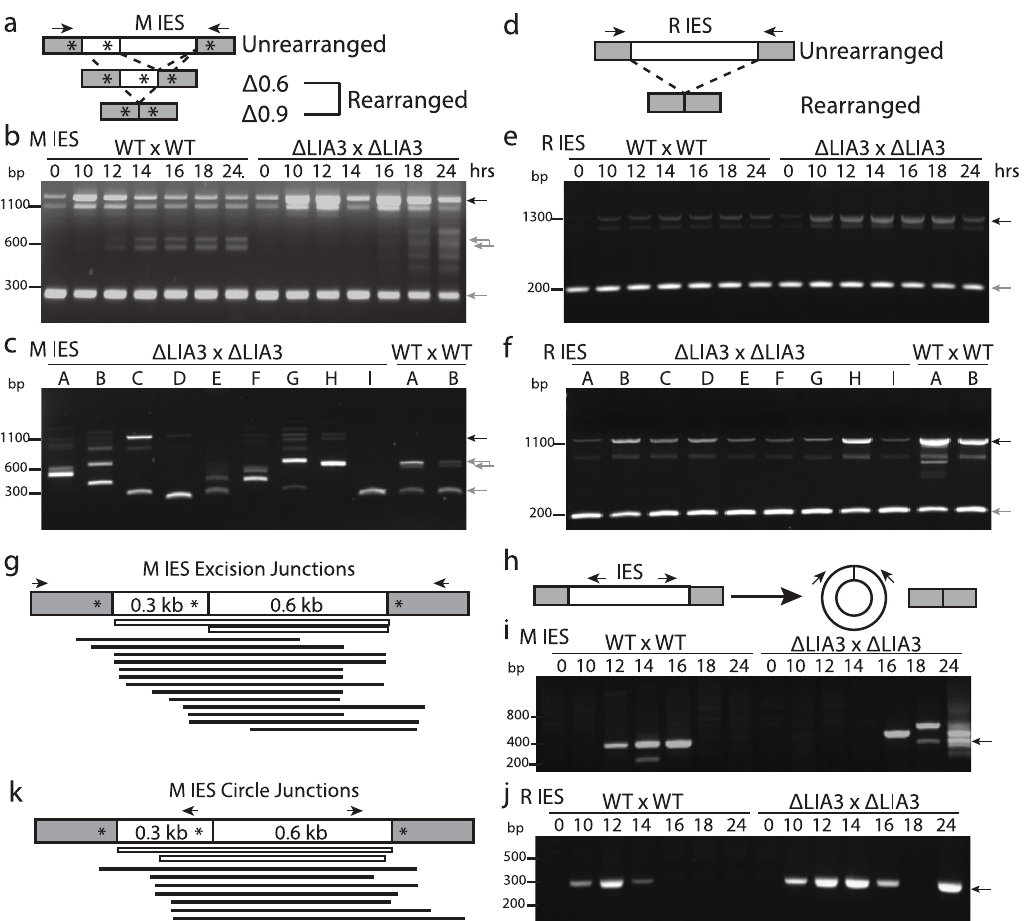
Fig 2. Excision of the M IES is aberrant and delayed in Δ LIA3 matings. (a and d) Diagram illustrating the alternative rearranged forms of the M IES (a) or R IES d). Grey boxes represent the macronucleus retained flanking regions; white boxes, the 0.6 kb and 0.3 kb eliminated sequences; asterisks, the A5G5 tracts; arrows, the location of the pcr primers used in b and c to amplify across the IES. (b and e) PCR of genomic DNA isolated from different timepoints throughout mating demonstrating that excision of the M IES (b) is both delayed and aberrant in Δ LIA3 matings while excision of the R IES is normal (e). (c and f) PCR of individual progeny confirming that excision of the M IES (c) is aberrant in Δ LIA3 matings whereas excision of the R IES (f) is comparable to WT matings. Black arrows point to the unrearranged form and single and double grey arrows point to the expected rearranged forms for b, c, e, and f. In b and c, the doublet observed for the 0.6 kbp M IES deletion reveals that some fraction of wild-type excision events are directed by a cryptic A5G5 tract (AAAGGAGG) rather than the major A5G5 boundary determinant. (g) Diagram displaying the sequenced junctions from individual Δ LIA3 progeny. A diagram of the M IES denotes the two alterative left boundaries, M1 and M2, and the right boundary M3. Within the IES diagram grey boxes represent the flanking regions; white boxes, the 0.6 kb and 0.3 kb eliminated region of the M IES; asterisks, A 5 G 5 tracts; arrows, pcr primers. Each thin, white and black boxes beneath the IES diagram represents the region excised from the progeny of either wt or Δ LIA3 matings, respectively. (h) The strategy to detect excised IES circles: PCR primers located within each IES point outward toward the boundaries and will only amplify a product if the excised region forms a circular intermediate. Grey boxes represent the flanking region; white boxes, the excised region; arrows, pcr primers. (i) PCR results for the excised M IES throughout mating. Primers will not amplify circular products utilizing the interior, right deletion boundary. Note: the lower band in the 14 hr WT mating sample corresponds to an alternative form seen multiple times in WT matings. (j) PCR results for the excised R IES throughout mating. Arrows in i and j point to the expected size of the circular product. (k) Diagram of the excised regions based on sequencing the circular intermediates from Fig 2j.